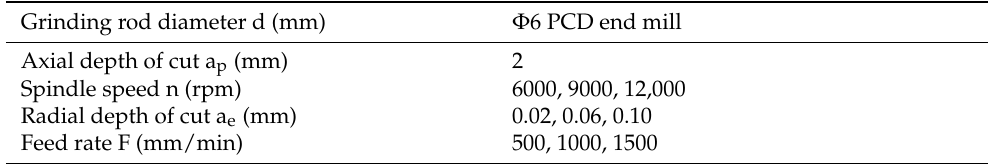
Table 2. L9 orthogonal parameter planning table.